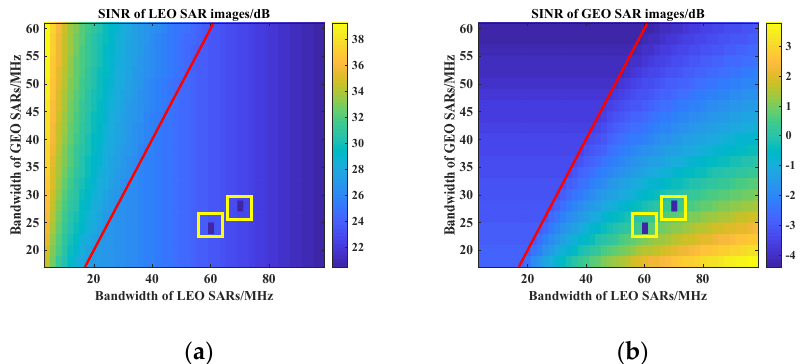
( b ) Figure 6. Results of BP algorithm. ( a ) point A, B, C, D; ( b ) the whole scene. Table 6. Power affecting a signal resolution cell from RFI.